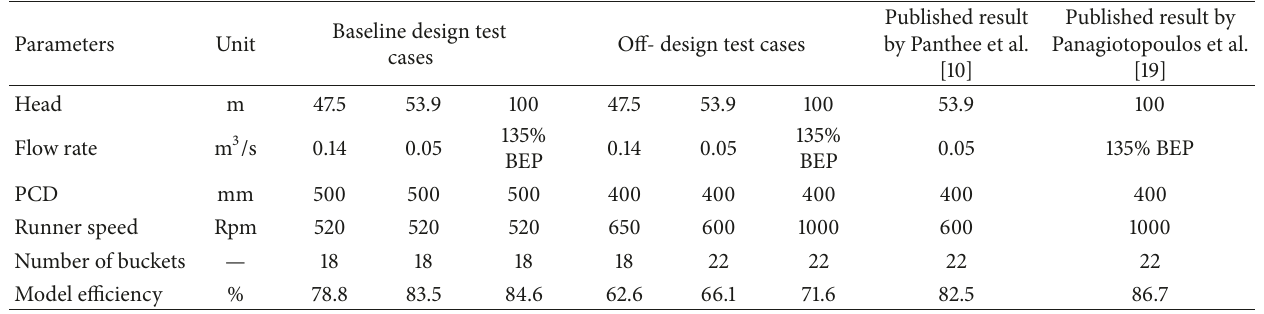
Table 11: Validation and performance prediction of Pelton runner.